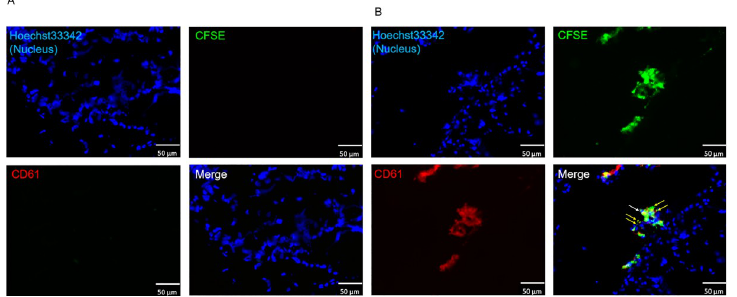
Fig 5. Immunohistochemical staining of thighbone using ex vivo production system (A) with or (B) without megakaryocytes introduction. The properties of platelet-like cells produced by the ex vivo production system were evaluated by immunohistochemical staining of the porcine thighbone. White arrows indicate introduced megakaryocytes while yellow arrows indicate CFSE-labeled, CD61+ platelet-like cells. Hoechst33342, CFSE, and anti- CD61 antibody are shown in blue, green, and red,